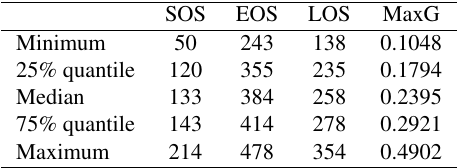
Table 1: Five-number summary 1 of phenological met- rics in the NATT area. The phenological metrics were the average of 11 years.